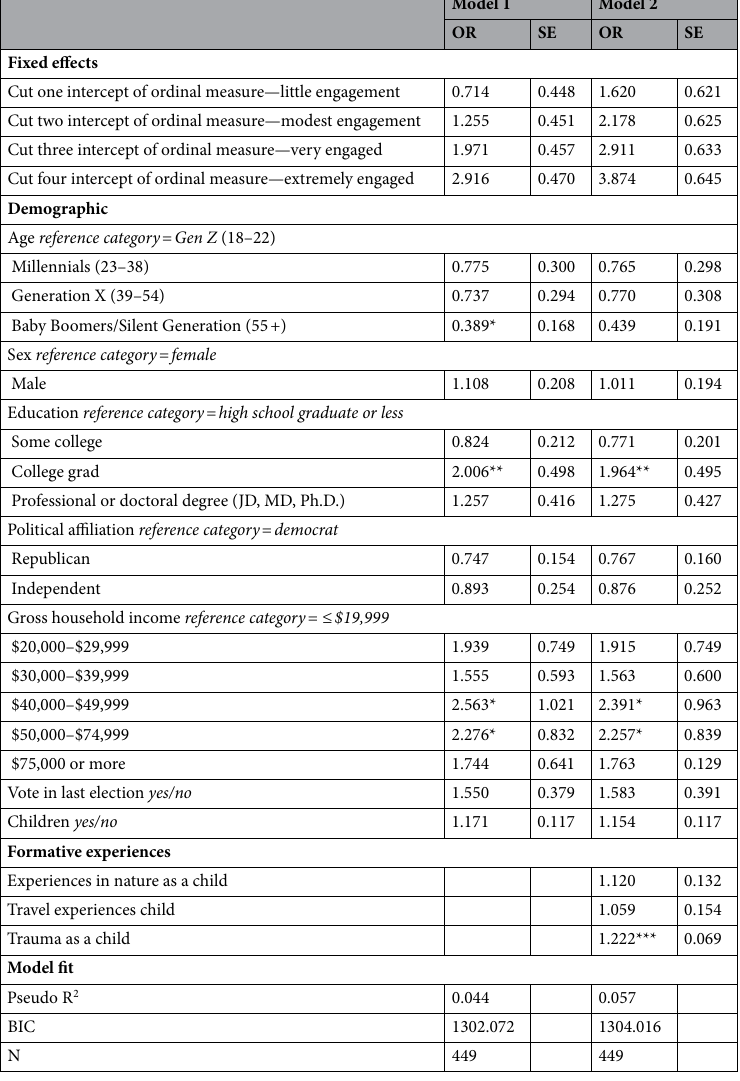
Table 2. Ordered logistic regression predicting civic engagement. Unstandardized coefficients reported *p < 0.05, **p < 0.01, ***p < 0.001. OR odds ratio, SE standard